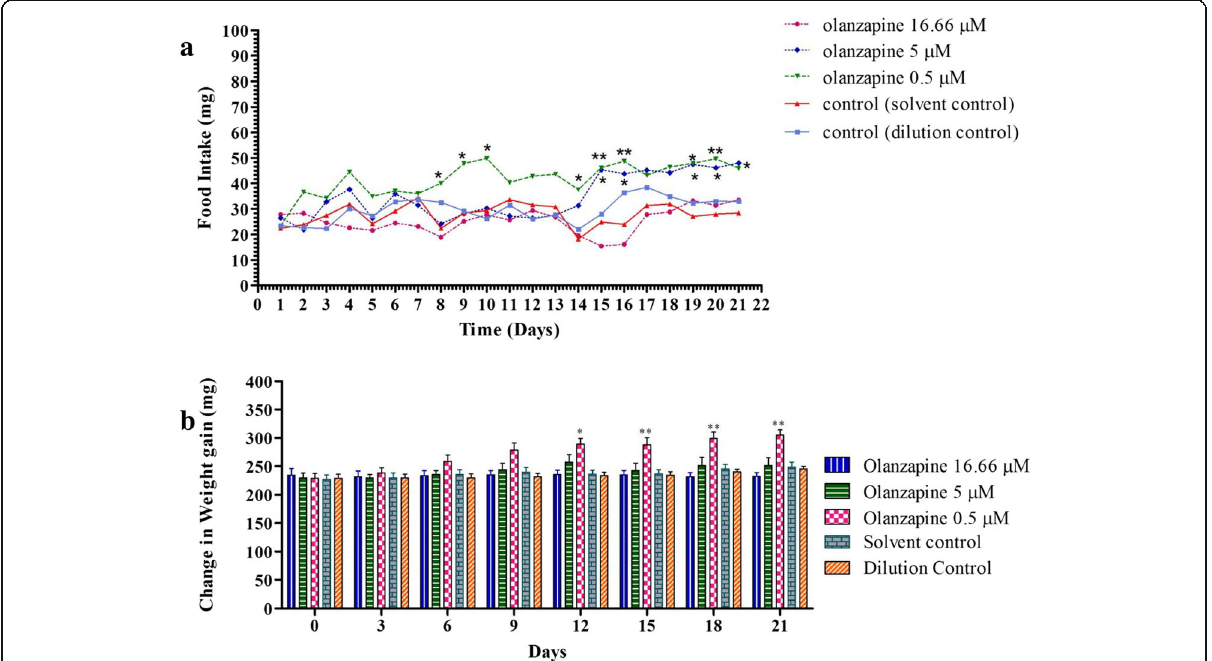
Fig. 7 Effect of olanzapine on a food intake and b body weight. All the data are expressed in mean ± SEM. Number of adult zebrafish in each group ( n ) = 6. * p < 0.05, ** p < 0.001 significantly different versus solvent